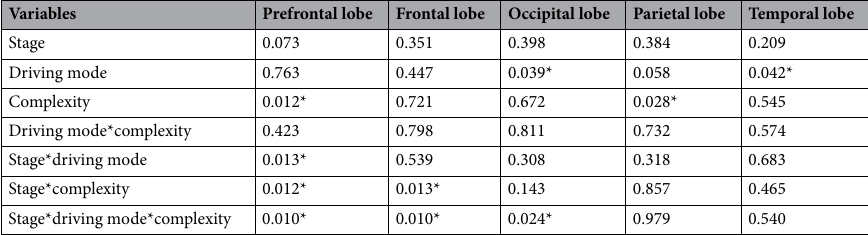
Table 3. A summary table of the ANOVA significance of EEG (*p < 0.05).